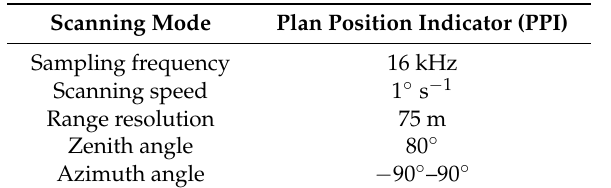
Table 2. Technical specifications of the scanning Doppler lidar.